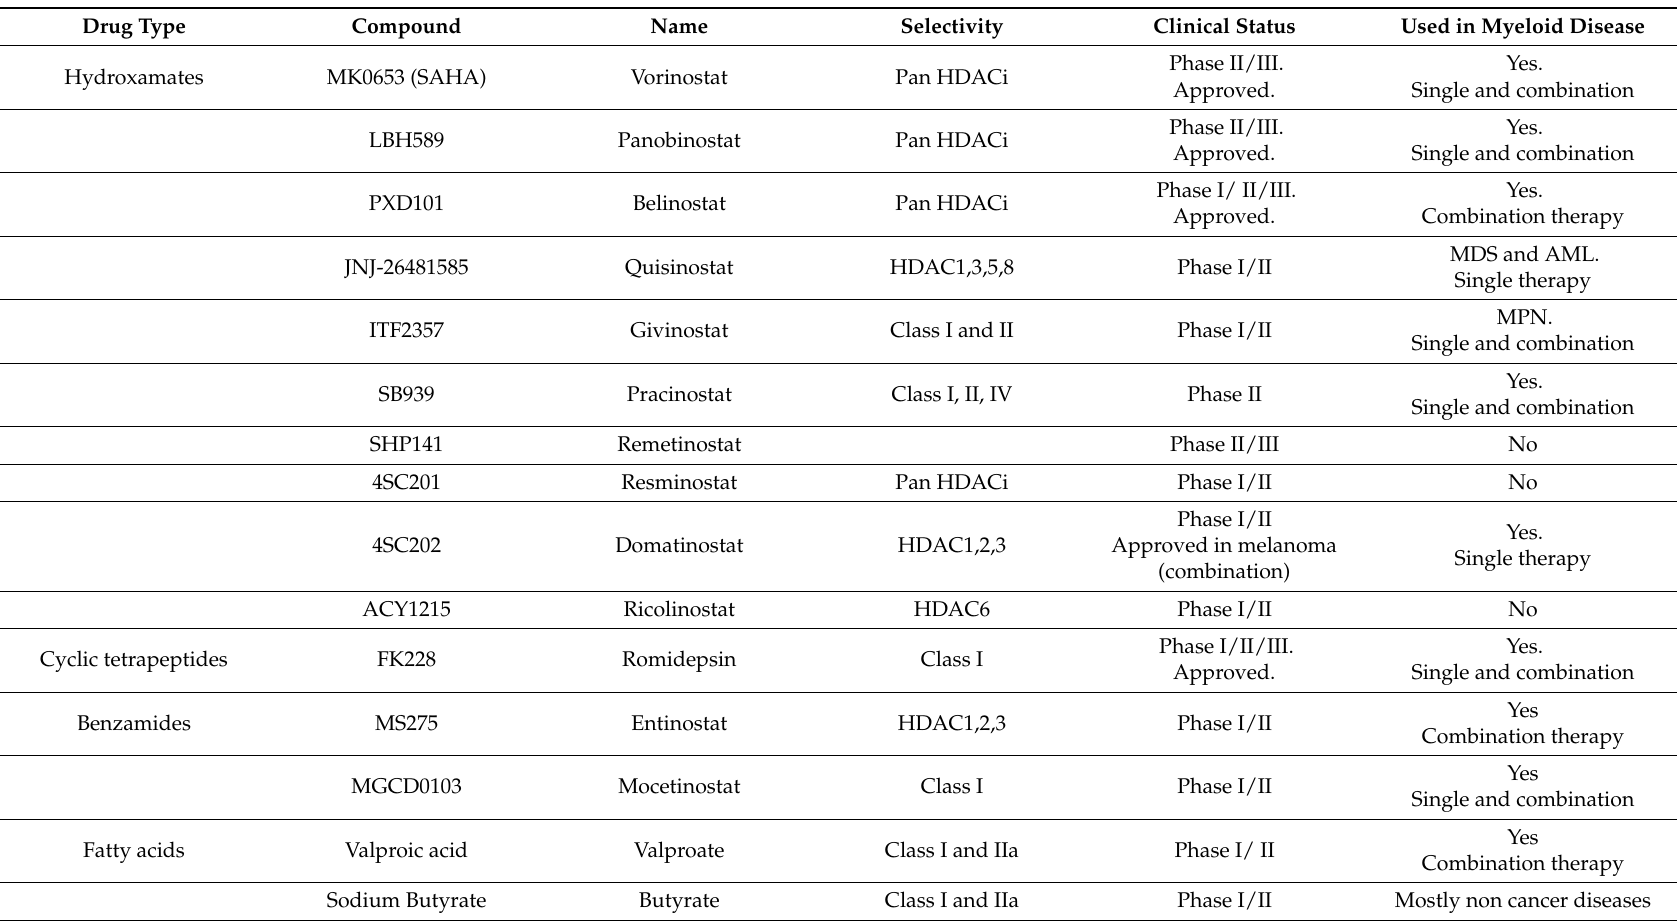
Table 3. HCACi that are listed at clinicaltrials.gov, with at least one listed phase I clinical